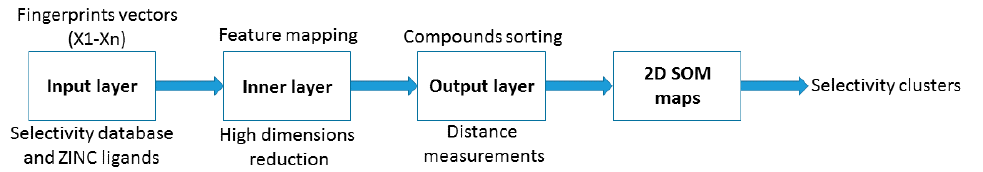
Figure 9. Chart for the generation of molecular selectivity SOM maps.